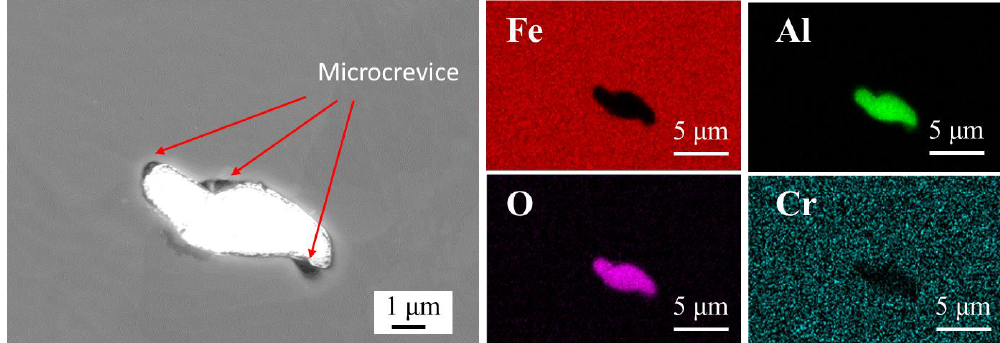
Figure 1. SEM image and EDS maps of inclusions in the steel.